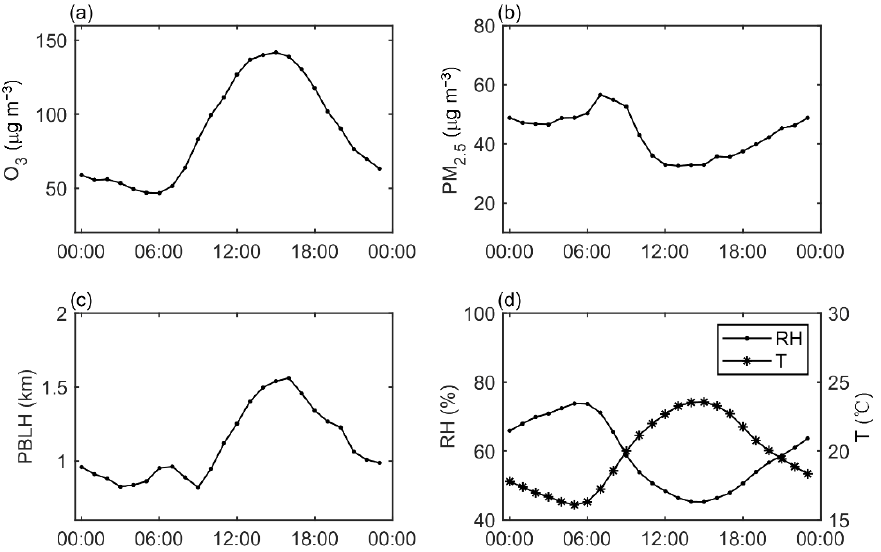
Figure 4. The average diurnal variations in ( a ) ozone concentration, ( b ) PM 2.5 concentration, ( c ) plan- etary boundary layer height, ( d ) relative humidity and temperature.